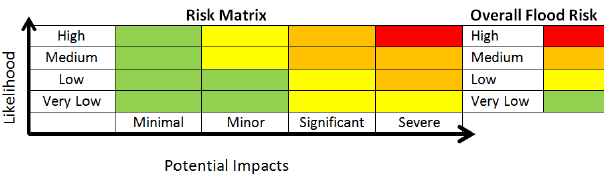
Figure 7. The flood risk matrix that is used across England, Scot- land, and Wales to communicate the likelihood and potential im- pacts of flooding. Source: Flood Forecasting